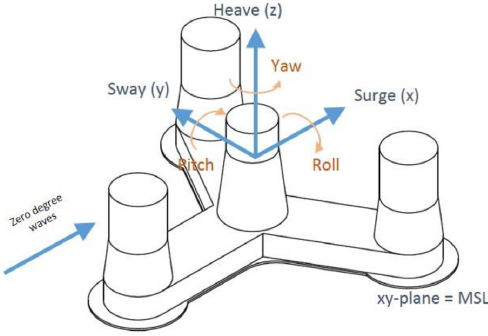
Figure 3. Sketch of the LIFES50 + public model of the Olav Olsen floater as used in this study.